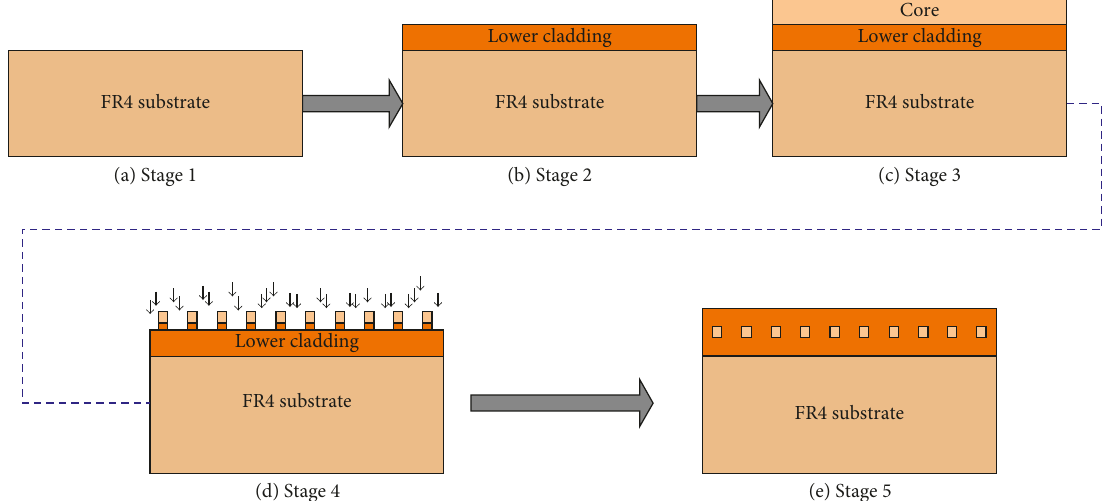
Figure 2: Key fabrication phases of laser ablation of multimode waveguides: (a) a base substrate of FR4, (b) formation of lower cladding by spin coating, (c) formation of the core layer, (d) laser ablation of the resulting sample from the core layer into the cladding layer, and (e) spin coating of the (optional) upper